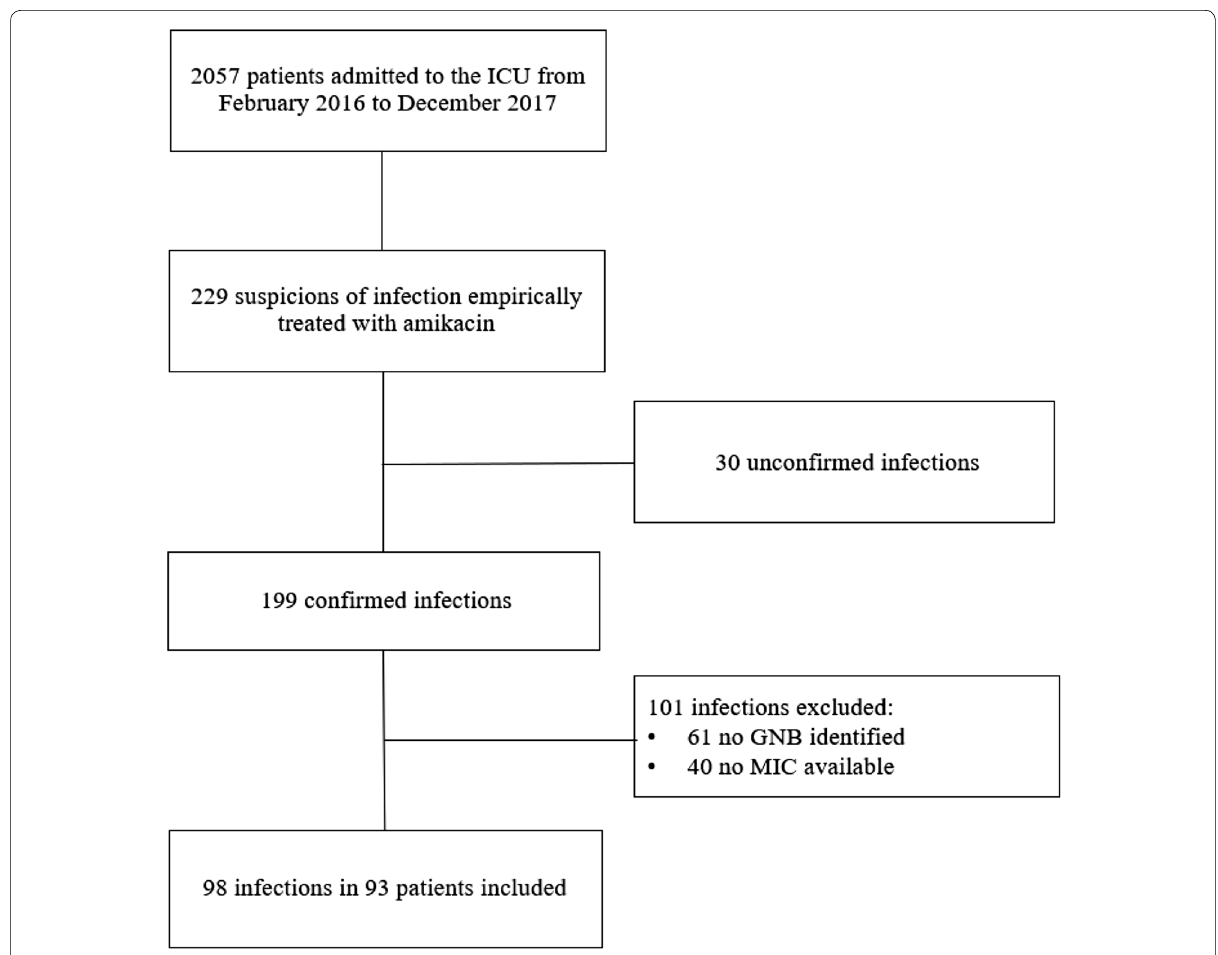
Fig. 1 Flowchart of the